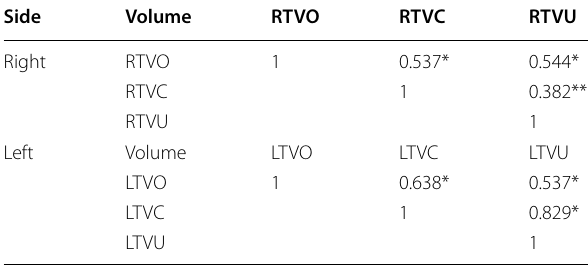
Table 2 Correlation matrix of the methods of testicular volume measurements by side